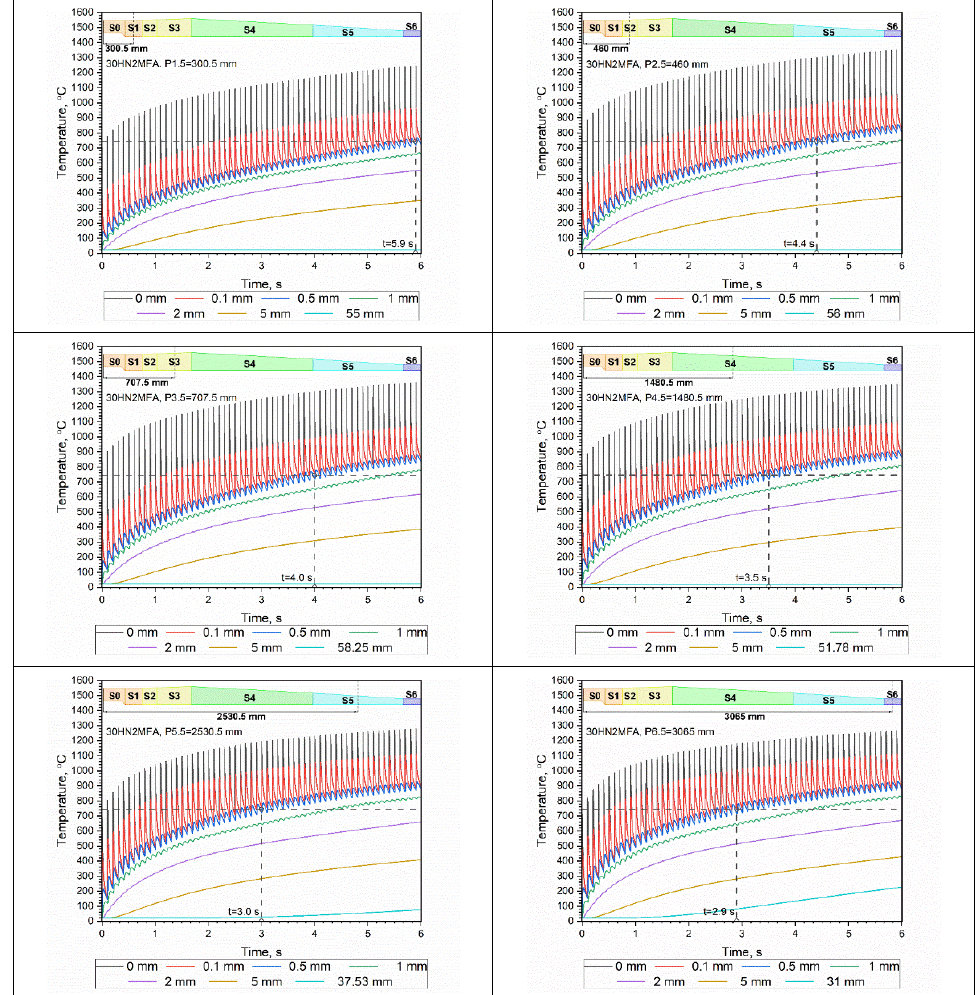
Figure 12. Temperature distribution T i ( t , r w , z ) along the barrel thickness at the zones S1 to S6 ( z in the middle of each zone) for the sequence of sixty shots, for the 30HN2MFA steel: black line—on the inner surface of the barrel, red line—0.1 mm below the inside surface, blue line—0.5 mm below the inside surface, green line—1 mm below the inside surface, violet line—2 mm under the inner surface, yellow line—5 mm under the inner surface, light blue line—on the outer surface of the barrel. The signs: P1.5—in the middle of the S1 zone, P2.5—in the middle of the S2 zone, etc.